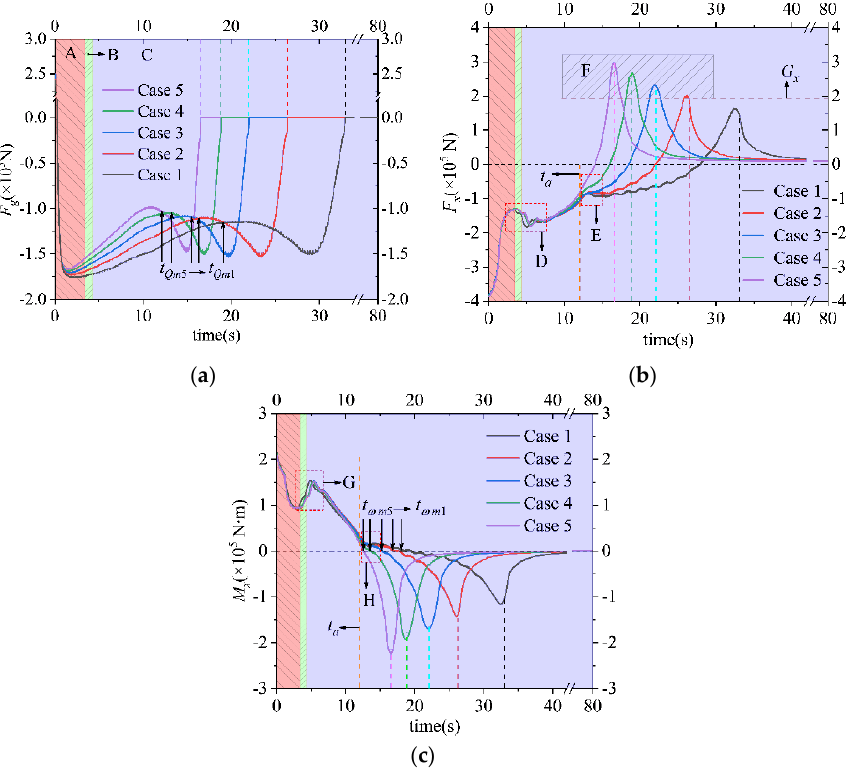
Figure 7. The variation in the hydraulic force and moment parameters during shut-off conditions in the five cases. ( a ) Wave force at the SG port; ( b ) axial force of impeller; ( c ) axial moment of the impeller.